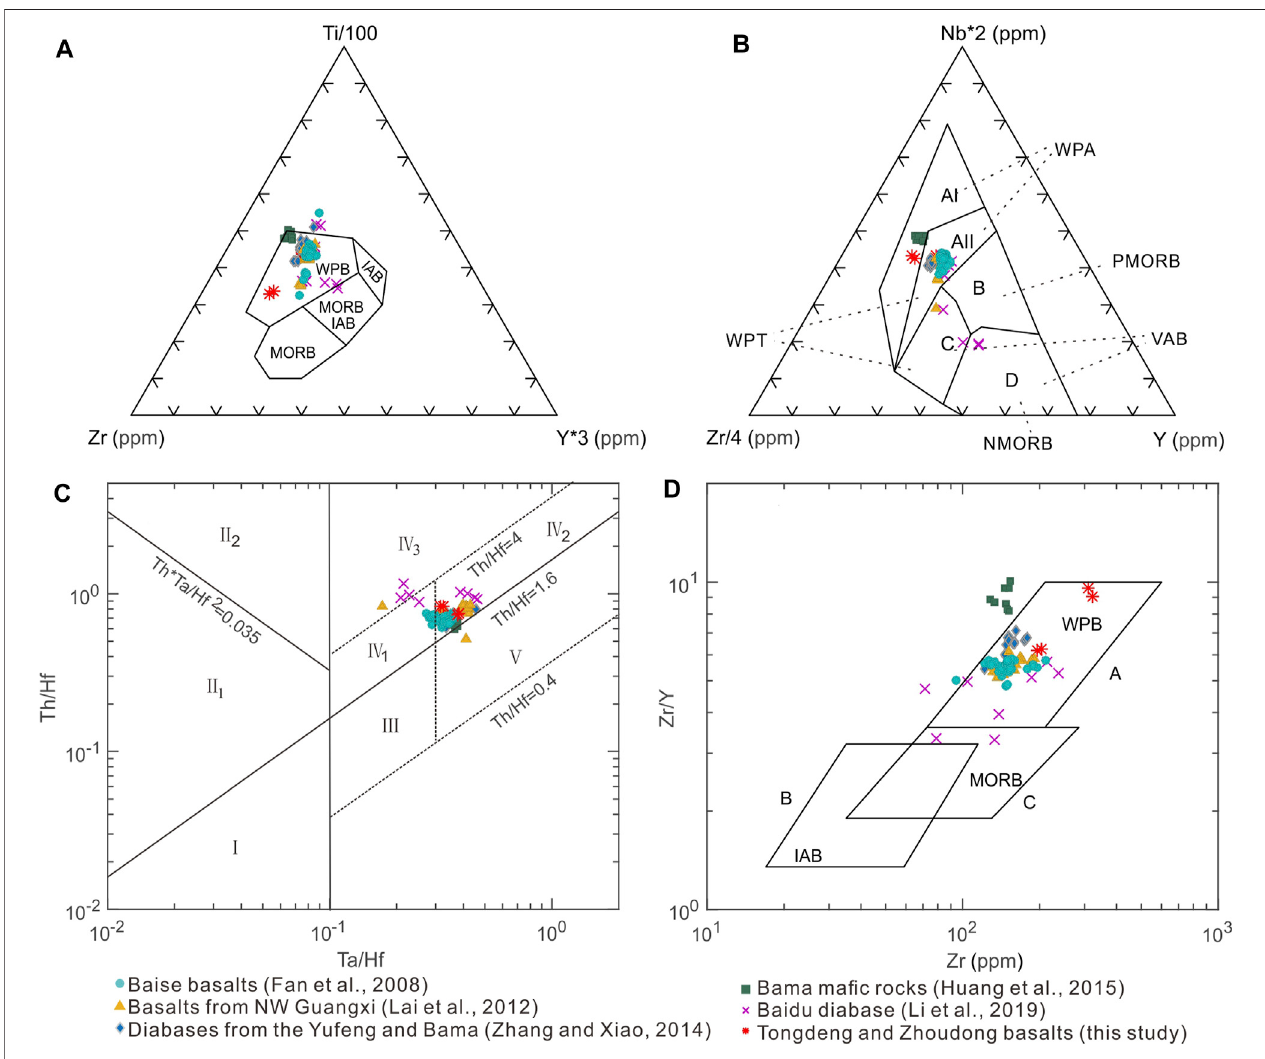
FIGURE 11 | Tectonic discrimination diagrams for the Longlin basalt samples: (A) Ti/100-Zr-Y*3 diagram (after Pearce and Cann, 1973); (B) Nb*2-Zr/4-Y diagram (after Meschede, 1986);Th/Hf-Ta/Hf diagram (after Wang et al., 2001);Zr/Y-Zr diagram (after Pearce, 1982). Datafrom other basaltunits in western Guangxi are shown for comparison. WPB – within-plate basalt; MORB – mid-ocean ridge basalt; IAB – island-arc basalt; WPA – within-plate alkali basalts; WPT – within-plate tholeiites; VAB – volcanic-arc basalts; PMORB – basalt from plume-in fl uenced regions; NMORB – oceanic basalt from normal mid-ocean ridge environment. (C) : I — N-MORB Margin of divergent oceanic plate; II — Margin of convergent plate (II 1 — Island are of continental margin; II 2 — Volcanic are of continental margin); III — Oceanic intra plate (the oceanic island and seamount, T-MORB, E-MORB); IV — Continental intraplate (IV 1 — Continental rift; IV 2 — Alkaline basalt zone; IV 3 — Tensional zone); V — Mantle plume; (D) 1 — Continental rift; 2 — Continental tensional